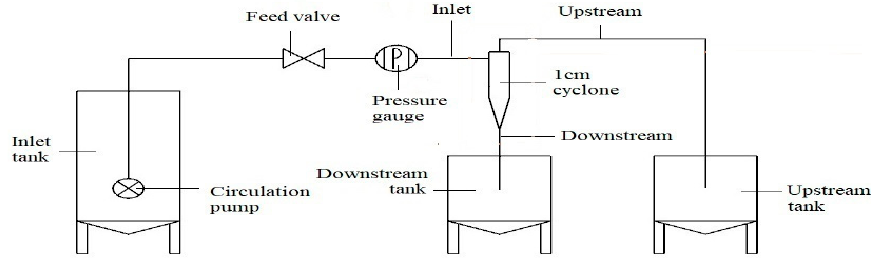
Figure 3. Schematic diagram of the hydrocyclone test.